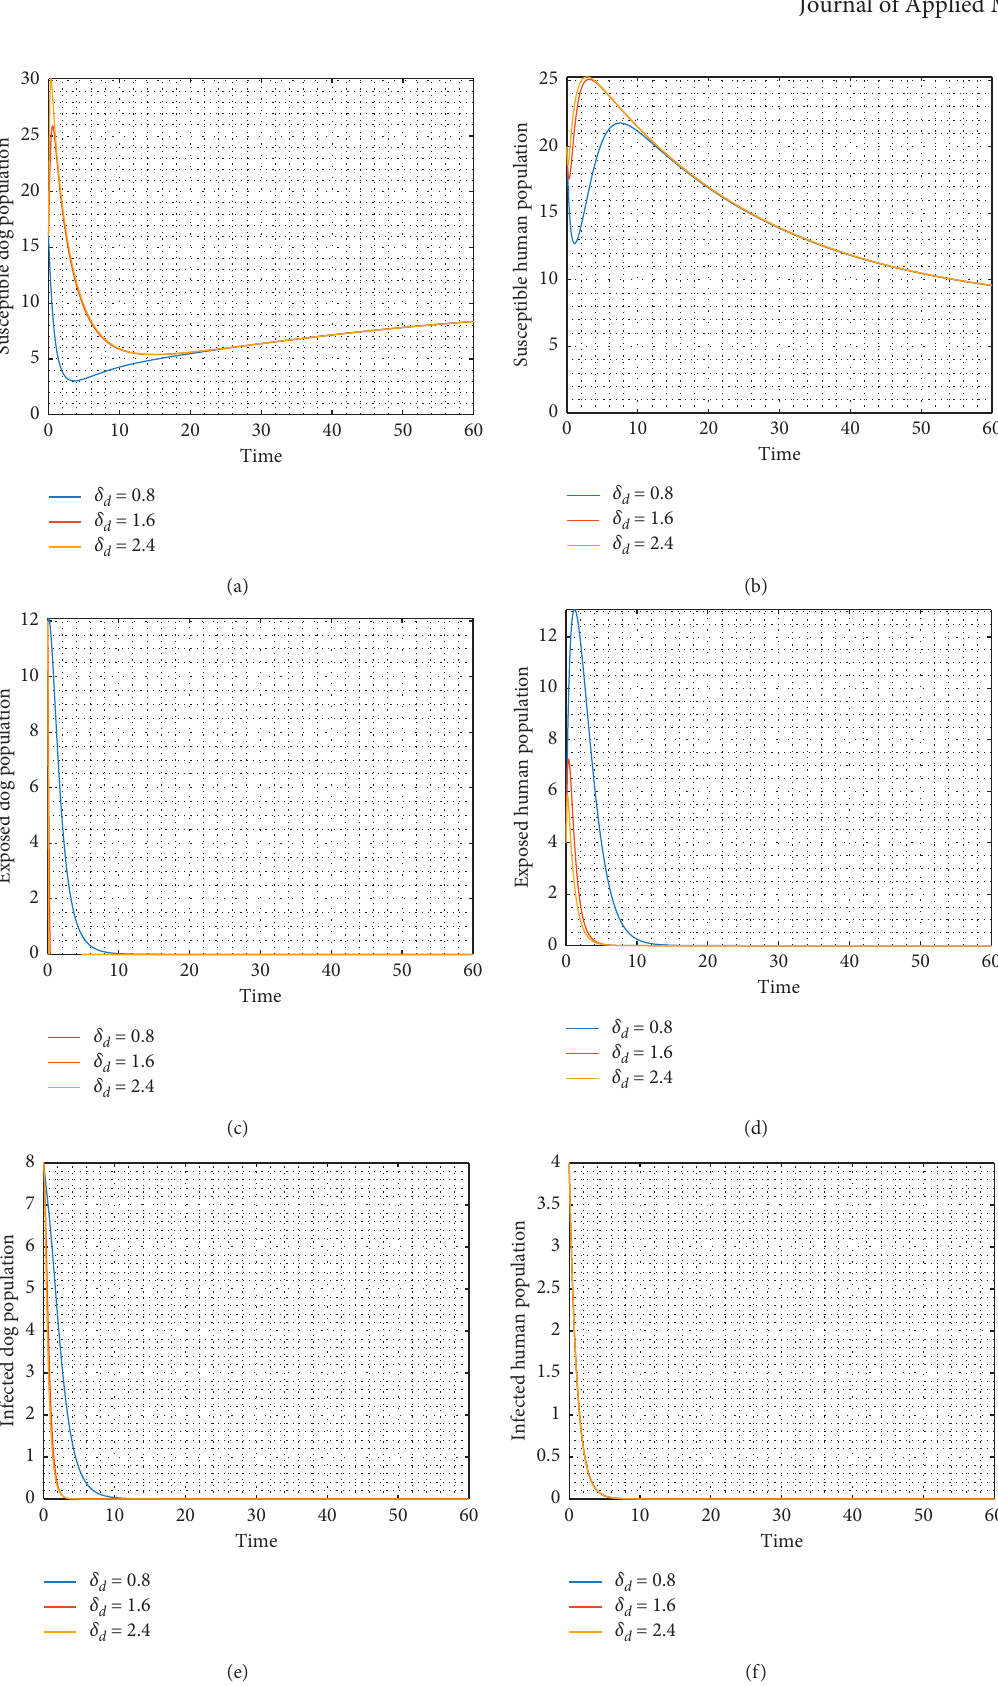
Figure 5: Solution curves of model (1) showing the effect of δ